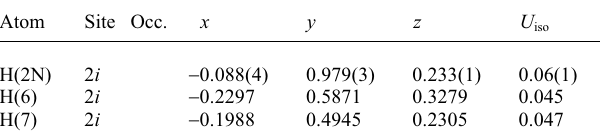
Table 2. Atomic coordinates and displacement parameters (in Å 2 )